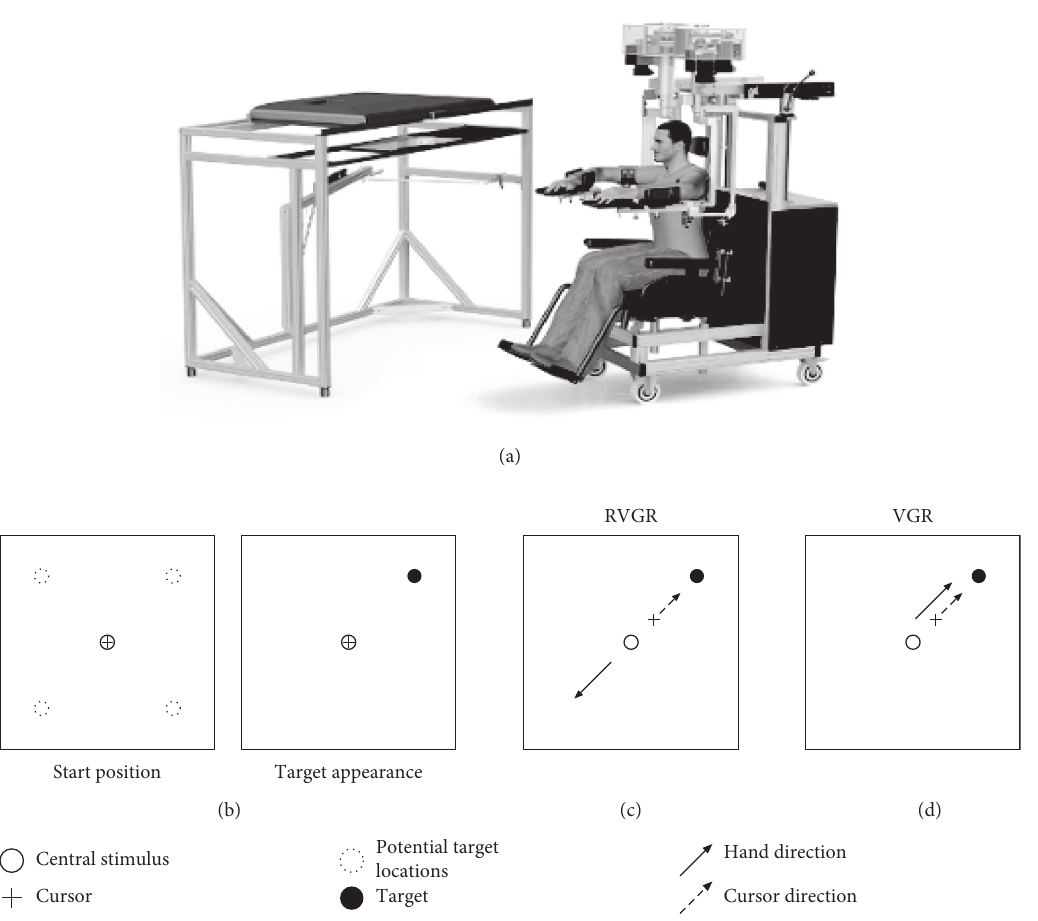
Figure 1: Kinarm robots and task schematics. (a) The Kinarm exoskeleton robot. (b) A schematic of the starting position and target appearance for both tasks. (c) Direction of the hand movement and cursor movement for the RVGR task. The cursor moves in the opposite direction of the hand movement. (d) Direction of the hand movement and cursor movement in the same direction for the VGR